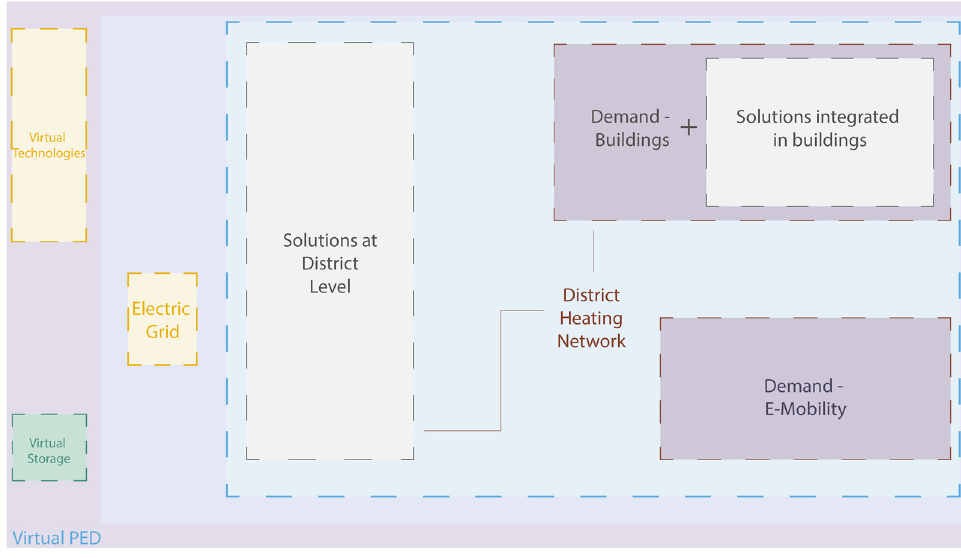
Figure 3. Virtual Figure 3. Virtual PED.